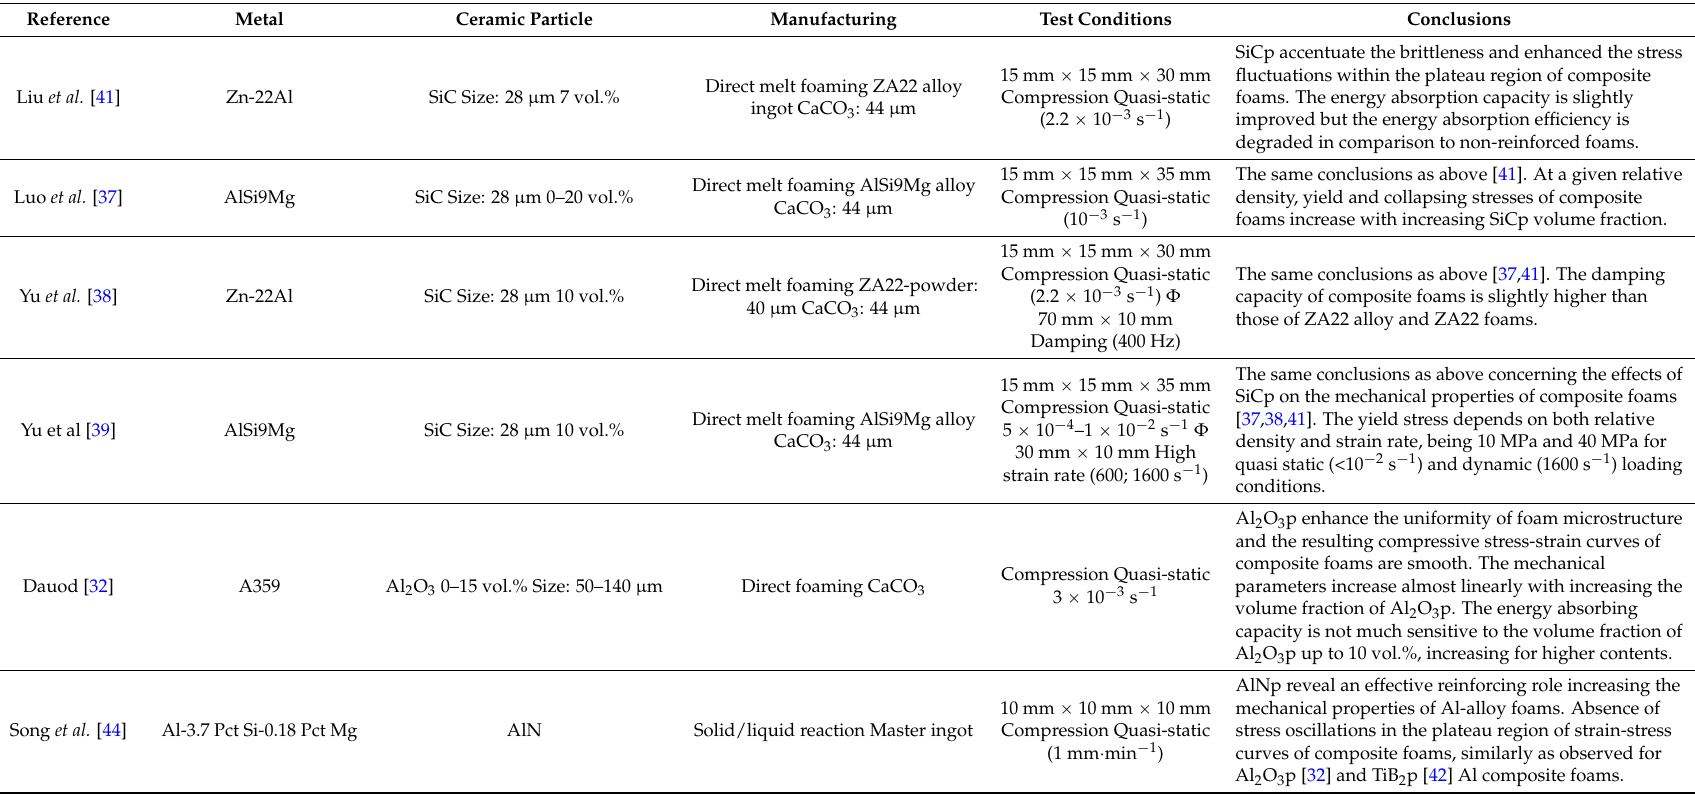
Table 2. Literature survey on ceramic particles reinforced foams prepared by direct foaming